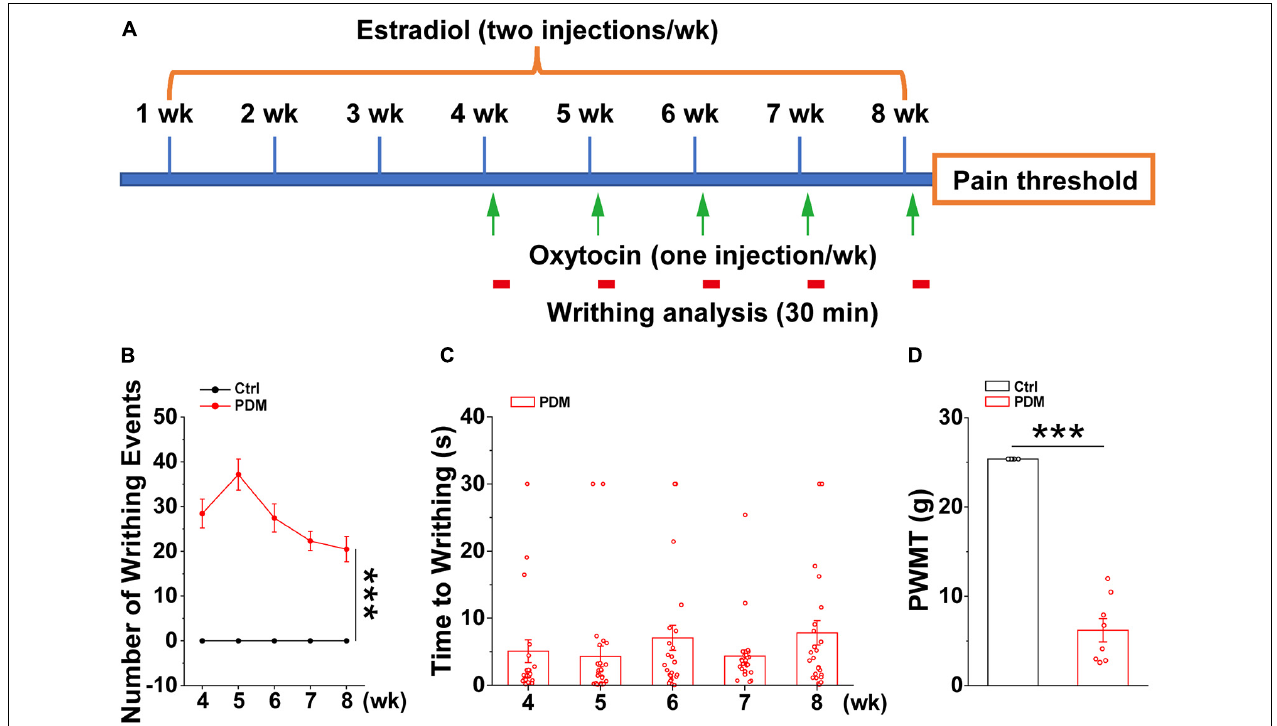
FIGURE 4 | Behavioral evaluations in model rats. Schematic diagram showing the timeline and treatments used in generating the pelvic pain model, together with subsequent measurements. Starting from week four, oxytocin or saline was injected 24 h after estradiol benzoate for pelvic pain (PP) and control animals, respectively (A) . Writhing and pain threshold was measured 24 h after the last dose of oxytocin or saline, LFPs were recorded on days 58 and 59. (B,C) Number of writhing events (30 min time window) (4 weeks: PP: 28.442 ± 3.217; 5 weeks: 37.154 ± 3.485; 6 weeks: 27.442 ± 3.156; 7 weeks: 22.308 ± 2.133; 8 weeks: 20.481 ± 2.789) ( t = 9.947, p = 1.627 × 10 - 18 ) and latency (4 weeks: 5.072 ± 1.694 s; 5 weeks: 4.302 ± 1.544 s; 6 weeks: 7.069 ± 1.882 s; 7 weeks: 4.334 ± 0.950 s; 8 weeks: 7.820 ± 1.834 s) ( n = 26). (D) Model rats show significantly reduced paw withdrawal mechanical threshold (PWMT) compared to control rats ( n = 8–10) (PP: 6.199 ± 1.296 g; Control: 25.368 ± 0.000 g) ( t = –16.667, p = 1.558 × 10 − 11 ), suggesting increased pain sensitivity in model rats, which is in agreement with observations in PDM women. Values represent mean ± SEM. *** p <